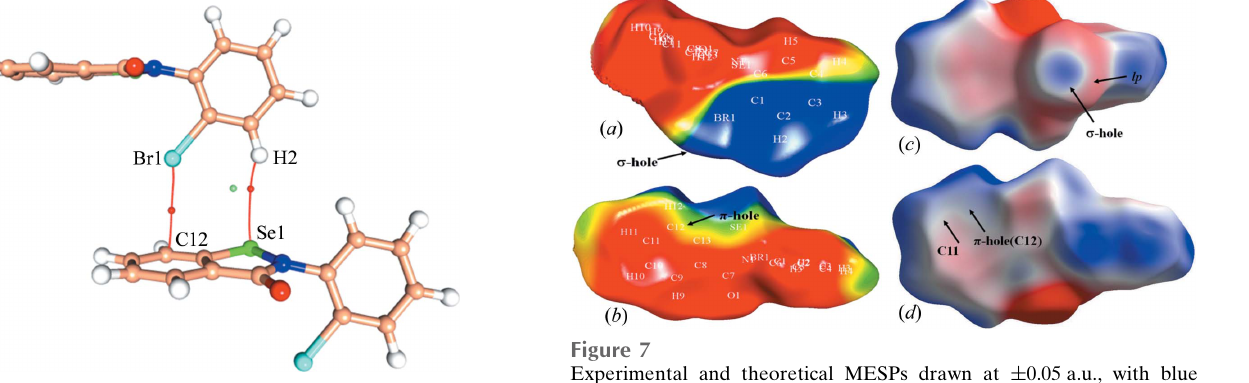
Figure 5 Experimental (3, (cid:4) 1) b.c.p. for Br1 (cid:2)(cid:2)(cid:2) C12 and H2 (cid:2)(cid:2)(cid:2) Se1 (blue points), and the (3, +1) ring critical point (green).